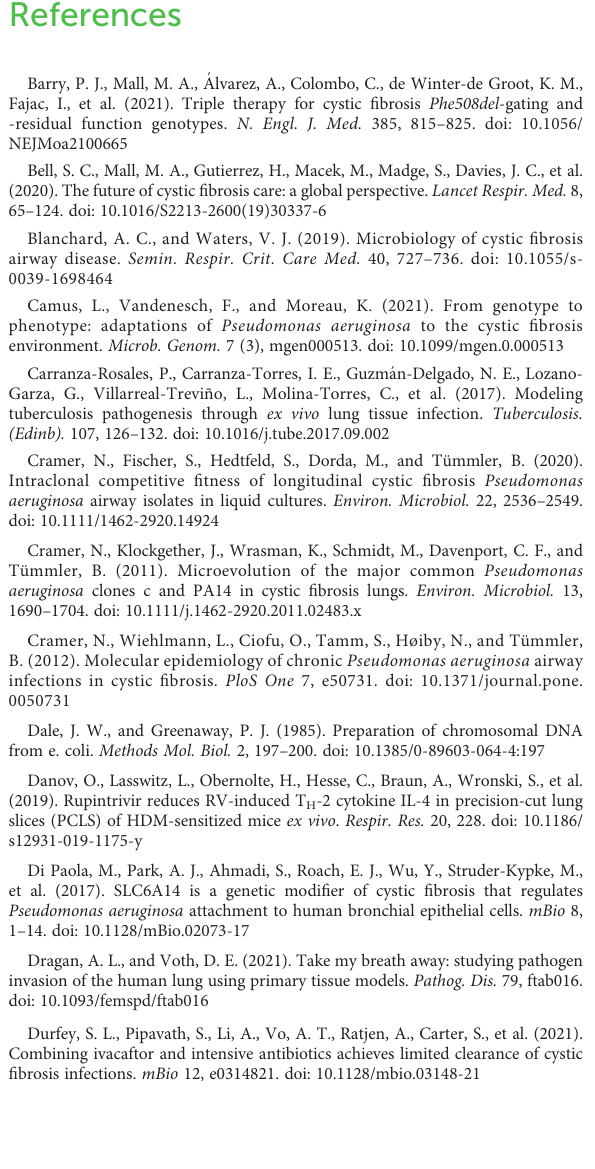
SUPPLEMENTARY DATA SHEET 1 Step-by-step explanation of the evaluation of the competition experiments in murine and human PCLS. SUPPLEMENTARY TABLE 1 Dataabout P.aeruginosa isolates(clone,isolate,CFpatient ’ sage,airwaycolonization time)andbiomaterial(patients ’ age,gender,diagnosis)chosenforhPCLS. SUPPLEMENTARY TABLE 2 Tests for normal distribution and variance homogeneity. To verify if the values are normally distributed, ANOVA as well as Kolmogorov-Smirnov were used. Variance homogeneity was checked via Levene test. SUPPLEMENTARY TABLE 3 Comparability of technical and biological replicates. SUPPLEMENTARY TABLE 4 Statistical analysis. Statistical tests for mPCLS and hPCLS are separated by different data sheets. Groups of the fi rst singletons, duos, trios, quartets, quintets and sextets were each compared to the sets of remaining